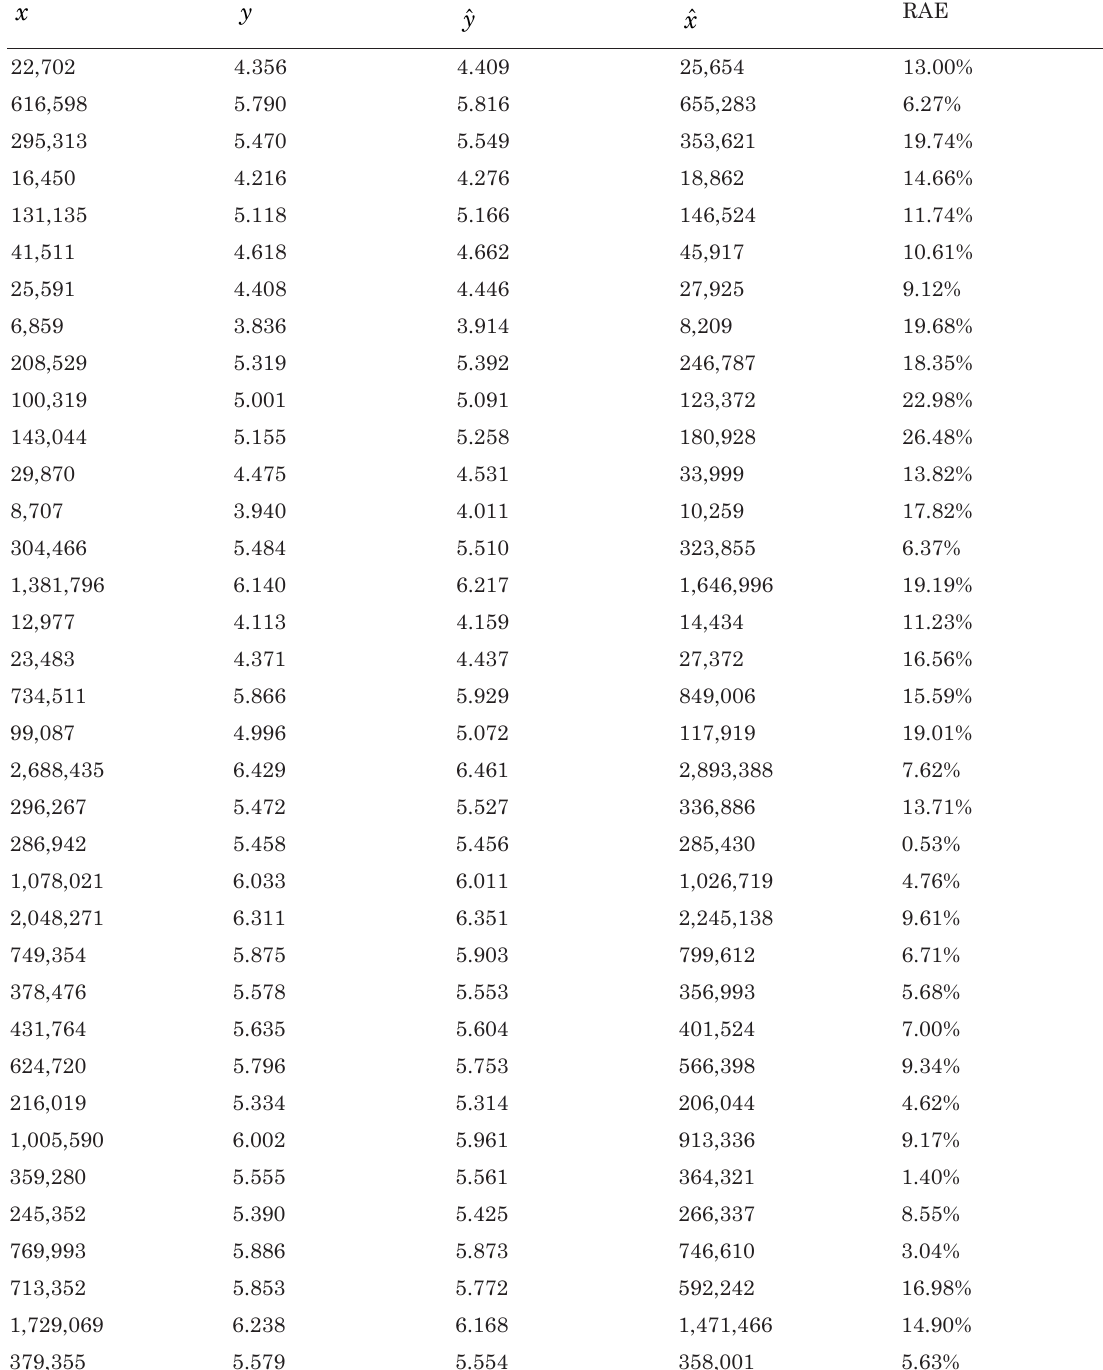
table 5. Prediction results of the repair